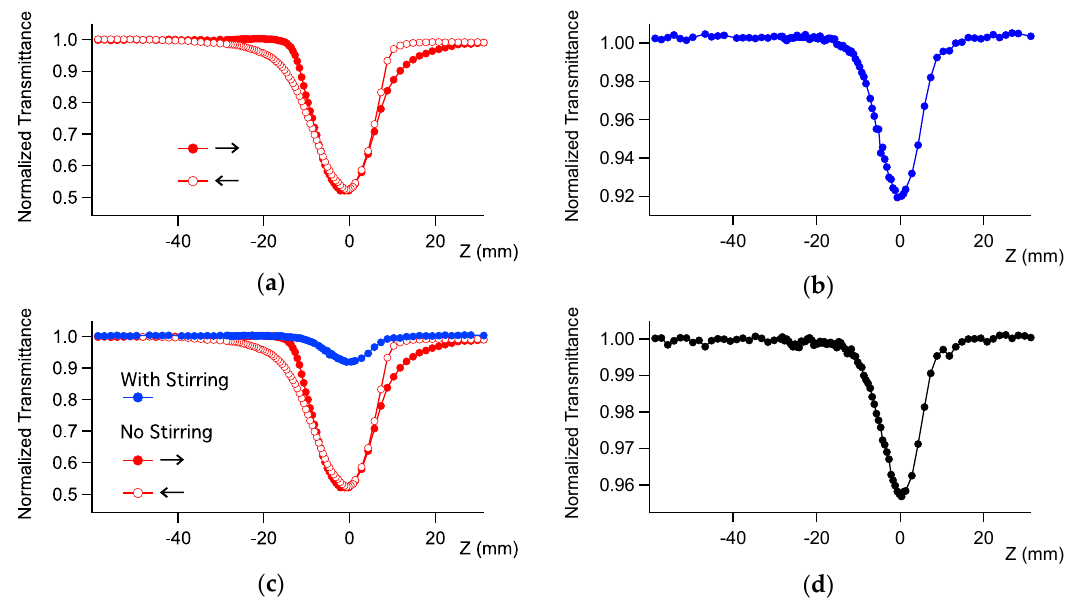
Inorganics 2019 , 7 , x FOR PEER REVIEW 6 of 12 scanning directions. ( d ) The trace of the known sample that only shows two-photon absorption (MPPBT/DMSO, see Section 4). The incident power was 0.4 mW.